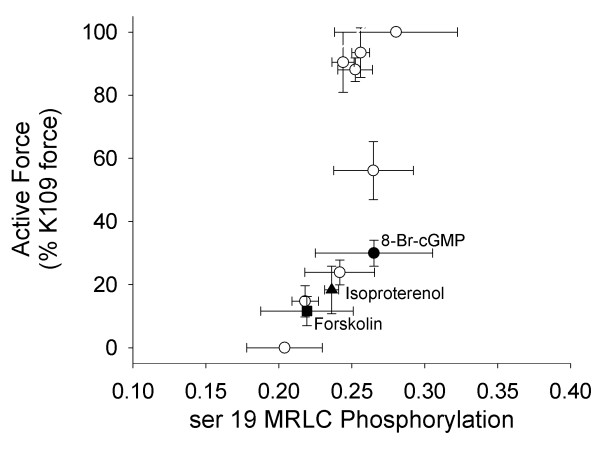
The steady-state relationship between active force and percent MRLC phosphorylation in the rabbit urinary bladder detrusor strips. Force is expressed as a percent of the initial response to 3 μM carbachol. The open circles show results from tissues were stimulated by varying doses of carbachol (0.01, 0.03, 0.1, 0.3, 1.0, 3.0, 10, 30, and 100 μM) until steady state was achieved (the data with carbachol alone previously published [11]). The symbol at 56% of force represents tissues stimulated with 0.3 μM carbachol. The filled symbols show results from tissues were stimulated 0.3 μM carbachol until steady state was achieved followed by addition of 300 μM 8-bromo-cGMP (filled circle), 10 μM forskolin (filled square), or 0.3 μM isoprenaline (filled triangle) until steady state was achieved.